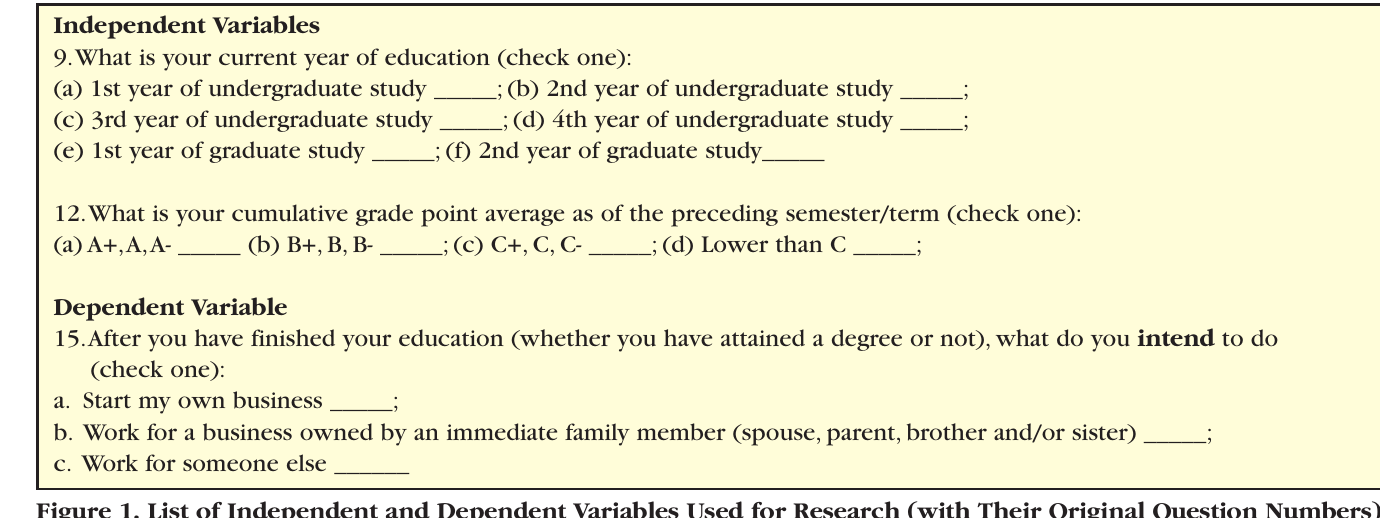
Figure 1. List of Independent and Dependent Variables Used for Research (with Their Original Question